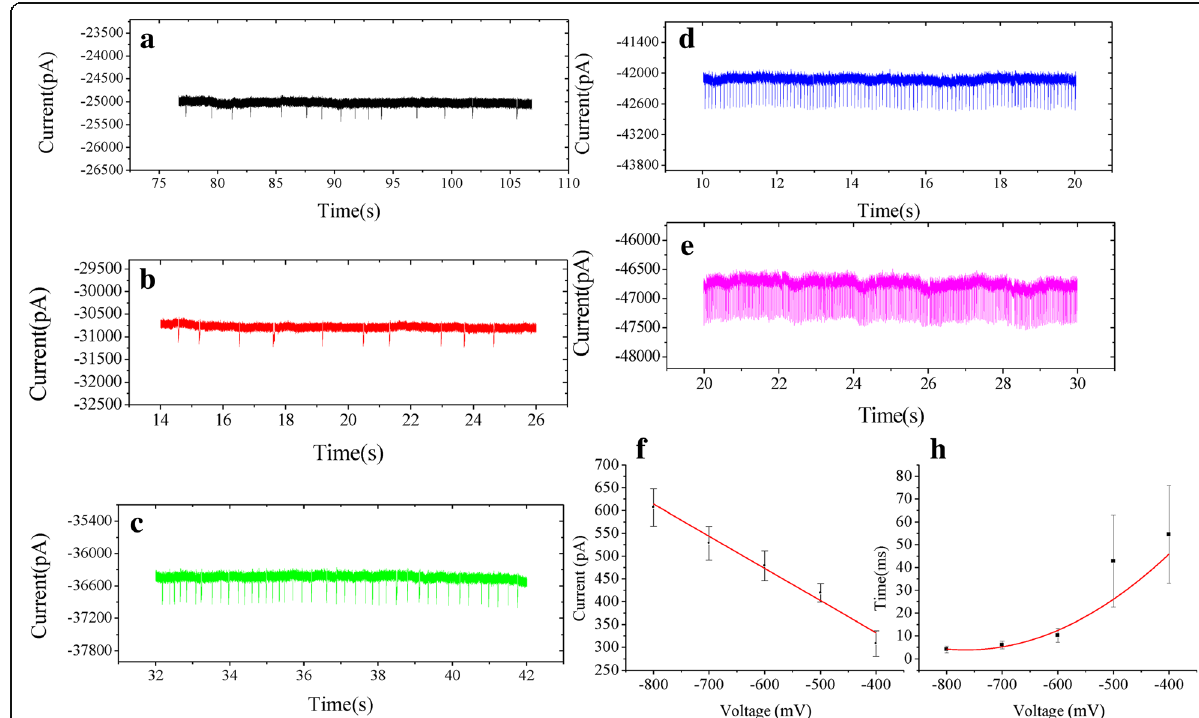
Fig. 3 a – e Schematic representation of the translocation events at different voltages from − 400 to − 800 mV. The frequency of translocation events increased when the applied voltage increased from − 400 mV to − 800 mV. f The current amplitude linearly increases with the voltage. h An exponentially decaying function ( t d ~ e − v/v0 ) was employed to fit the dwell time dependent on the applied voltages